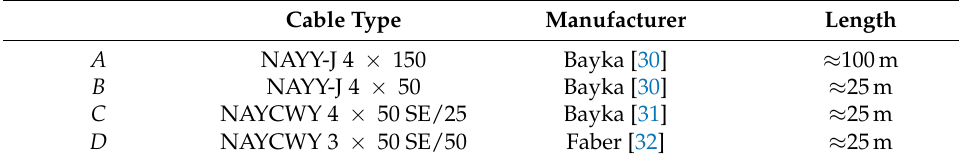
Table 5. Test cables for measurements.